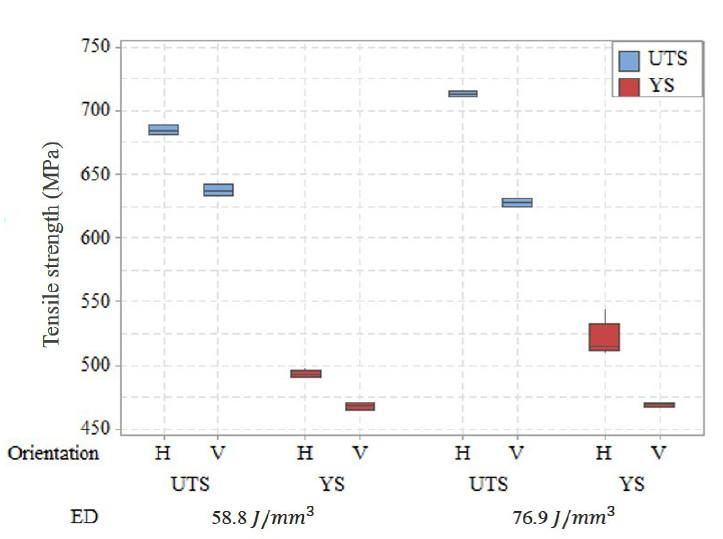
Figure 4. Tensile strength (YS and UTS) of horizontal and vertical specimens for energy densities 58.8 and 76.9 J/mm 3 .